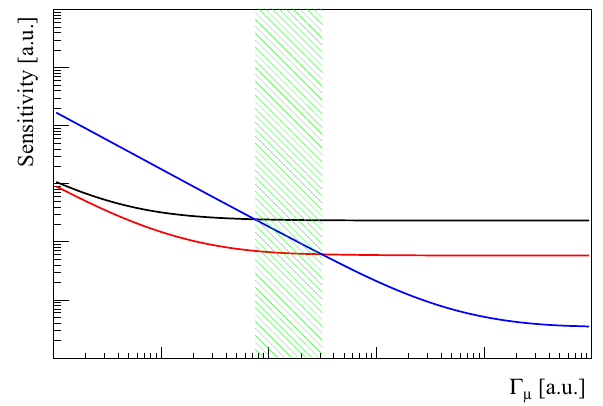
Fig. 2 Sensitivity trends as a function of the beam intensity, for a calorimetry-based design (black), a photon-conversion-based design with unchanged positron resolutions (blue) and a calorimetry-based design with a factor two improvement in resolutions (red). See the text for a detailed